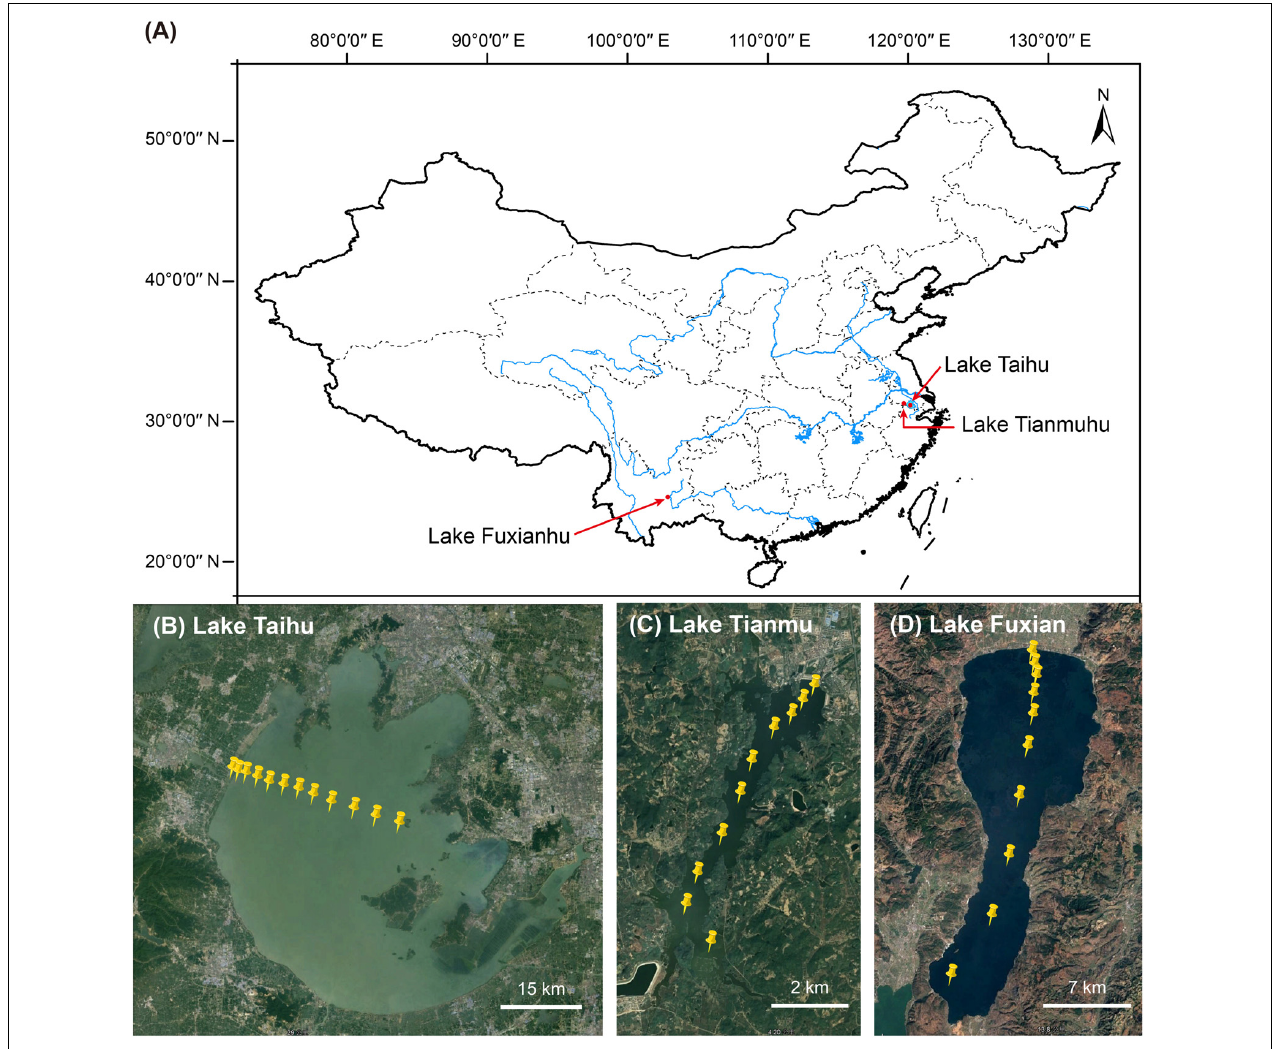
FIGURE 1 | (A) Map of China showing the location of the three lakes. Satellite images showing the sampling sites in (B) Lake Taihu ( n = 12), (C) Lake Tianmu ( n = 10), and (D) Lake Fuxian ( n =